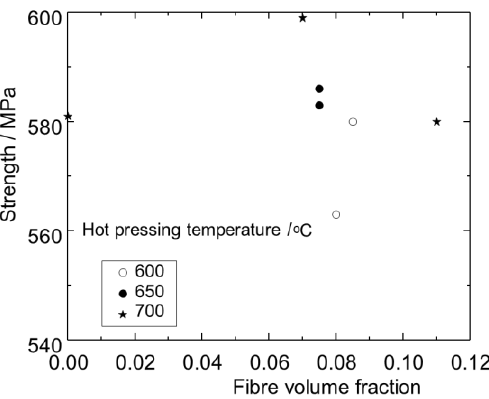
Figure 16. Tensile strength of short carbon fibre–titanium matrix composites obtained by hot pressing at the temperatures shown in the graph field under 200 MPa for 1 h versus the fibre volume fraction. Experimental data published in [57].